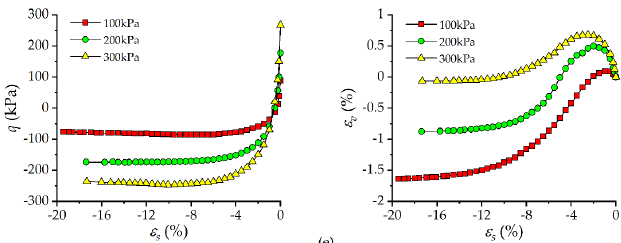
Figure 6. Stress − strain curves and volumetric strain − shear strain curves of the soil in: ( a ) BL tests; ( b ) AL tests; ( c ) CP tests; ( d ) LU tests; ( e ) AU tests. In order to investigate the influence of stress path on the stress–strain behavior of the UGRS, the q – ε s and ε v – ε s curves of soil specimens under the same consolidation pressure but different loading angles are provided in Figure 7. Stress paths make a significant dif- ference to the deformation characteristics of the UGRS. As can be seen, a considerable decrease in failure strain is observed as the loading angle increases for compression tests with α = 56.3°, 71.6°, 90° and 123.7° under the same consolidation pressure. This observa- tion will be discussed later in this section in a quantitative manner. As for the volume change behavior, the role of the stress path is evident: soil specimens show less volume contraction as the loading angle increases. For the same increment of deviator stress Δ q , the corresponding increment of mean effective stress Δ p’ decreases and even becomes negative as the loading angle increases. Different ratios of Δ q to Δ p’ cause different relative magnitudes of distortion and compaction of soil fabric. This may explain the differences in the ε v – ε s curves under different stress paths.